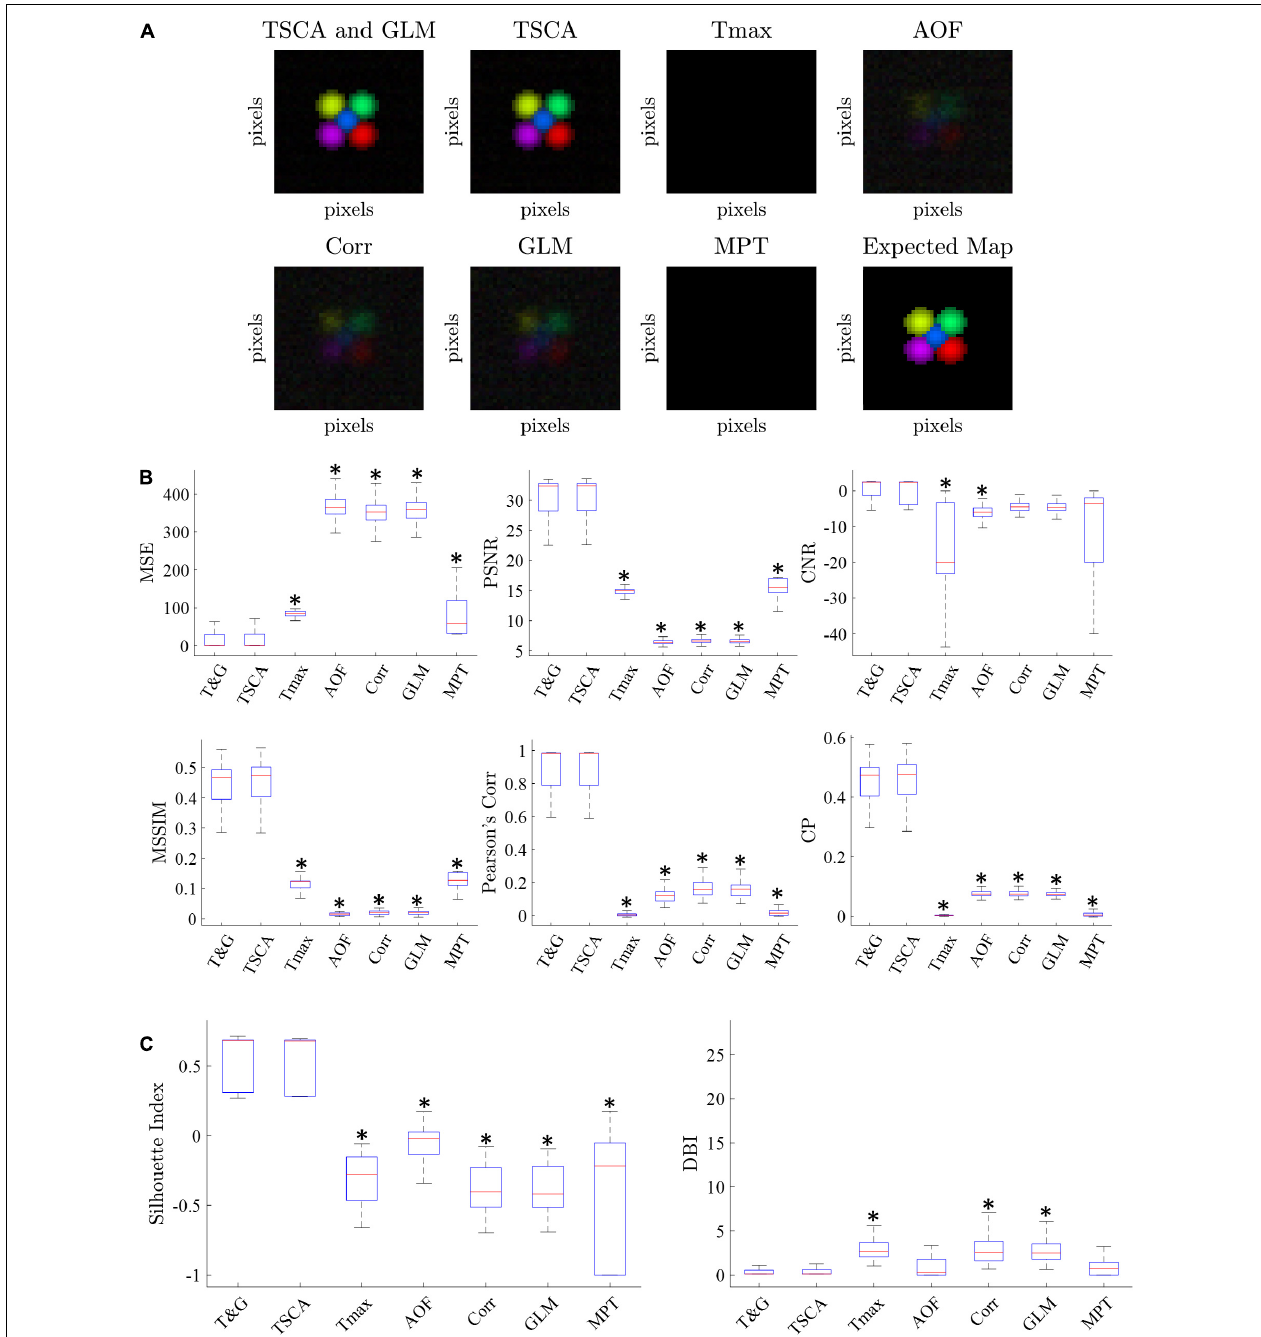
FIGURE 3 | Simulated data retinotopic maps. (A) An average “retinotopic map” generated by each method, following 100 repetitions of simulated stimuli with an SNR = –10 dB. (B) The six statistical performance evaluation measures of the generated retinotopic maps presented in (A) . MSE, Mean Square Error; PSNR, Peak Signal-to-Noise Ratio; CNR, Contrast-to-Noise Ratio; MSSIM, Mean Structure Similarity Index; CC, Correlation Coefficient; CP, Correlation Parameter (CP). ∗ Significantly Different than the TSCA and TSCA & GLM methods ( p < 0.05). (C) Cluster evaluation metrics of the generated retinotopic maps presented in (A) . The Silhouette index (left) and DBI (right). Significantly Different than the TSCA and TSCA and GLM methods ( p < 0.05).